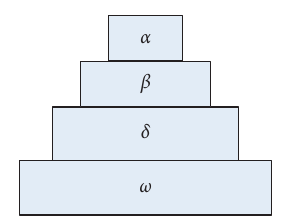
Figure 1: Social hierarchy of gray